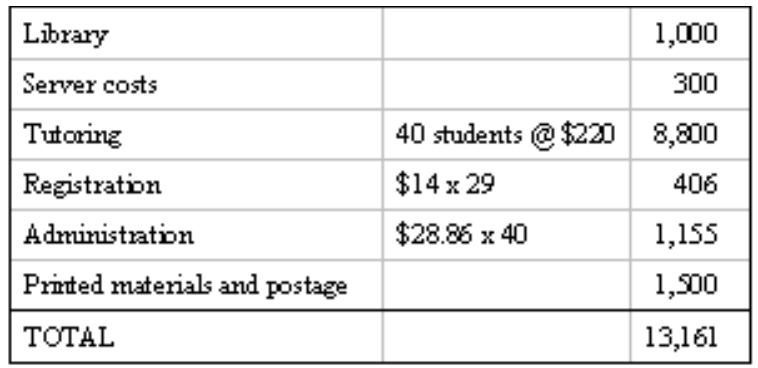
Table 2: Sample Course Delivery